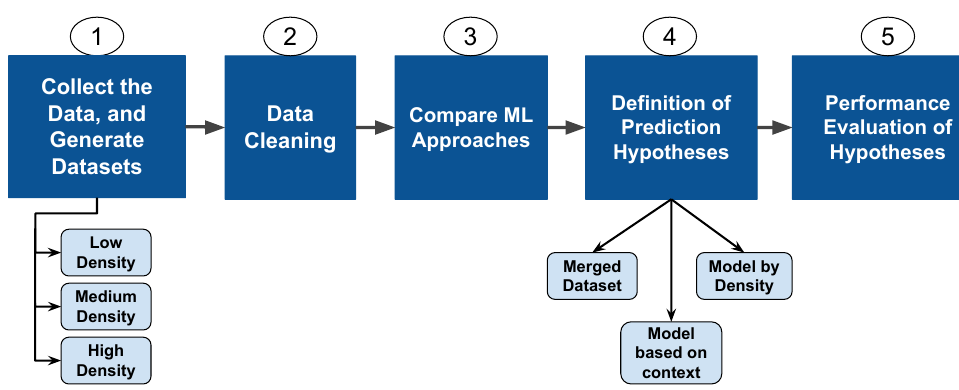
Figure 9. Workflow of the link lifetime prediction improvement